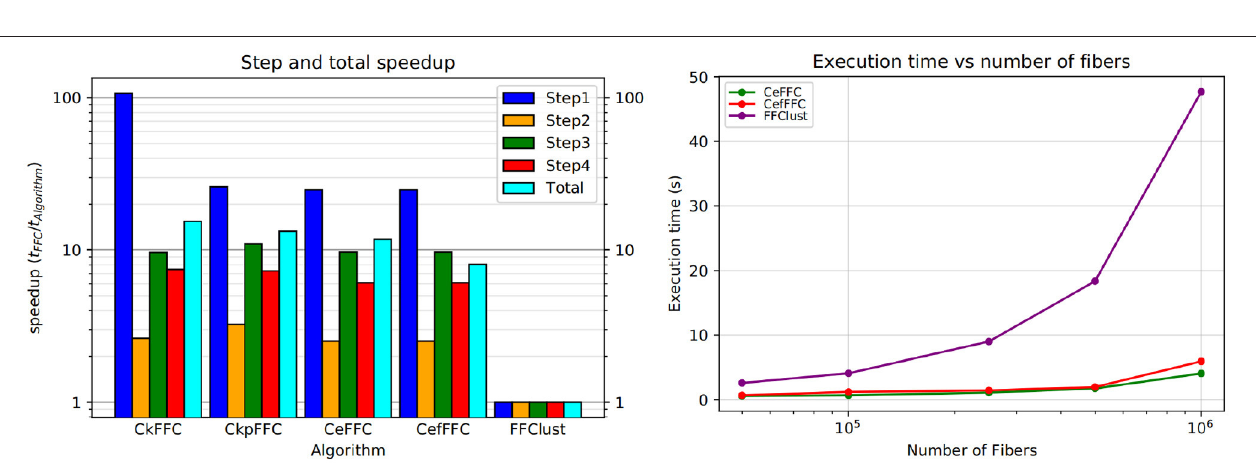
FIGURE 8 | Normalized DB-Index on the left and Execution times in log scale on the right. The CeFFC alternative achieves a DB almost as good as FFClust. The CeFFC alternative, which filters out clusters with intra-distance over 70 mm, achieves a slightly better DB than FFClust. All parallel alternatives improve execution times of FFClust in an order of magnitude. Note that the lowest execution time value in Y axis is 0.1 s.